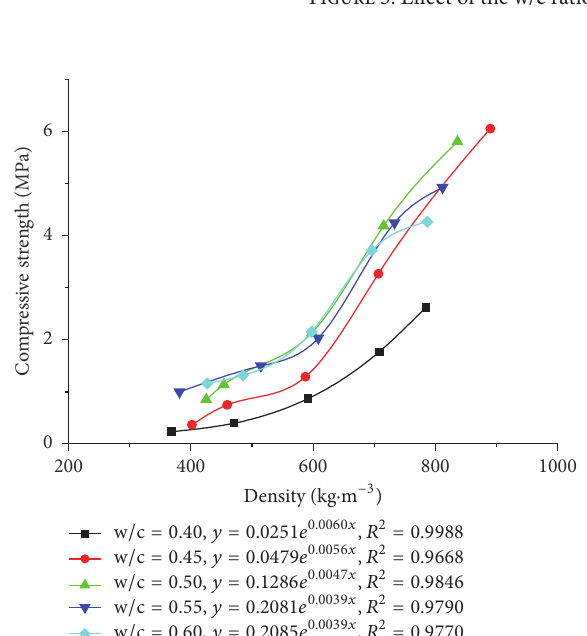
Figure 5: Effect of the w/c ratio on the porosity of the foam concrete.